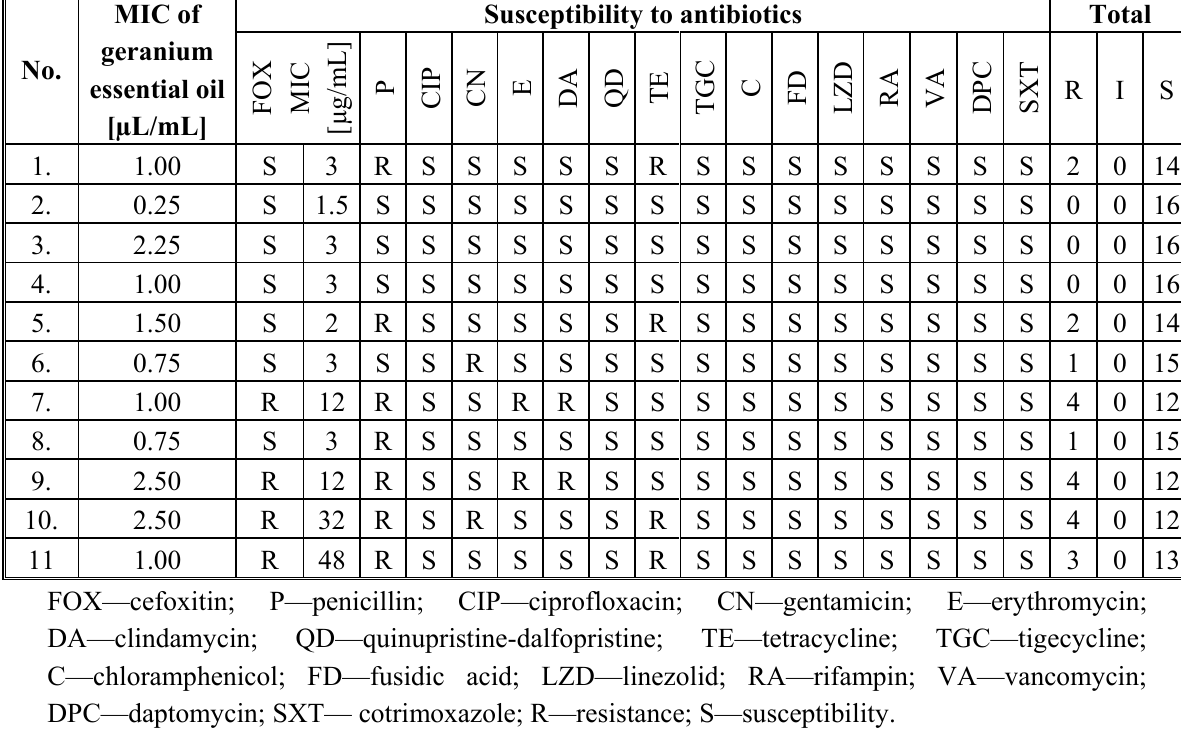
Table 7. Characteristics of S. aureus strains isolated from the throat.